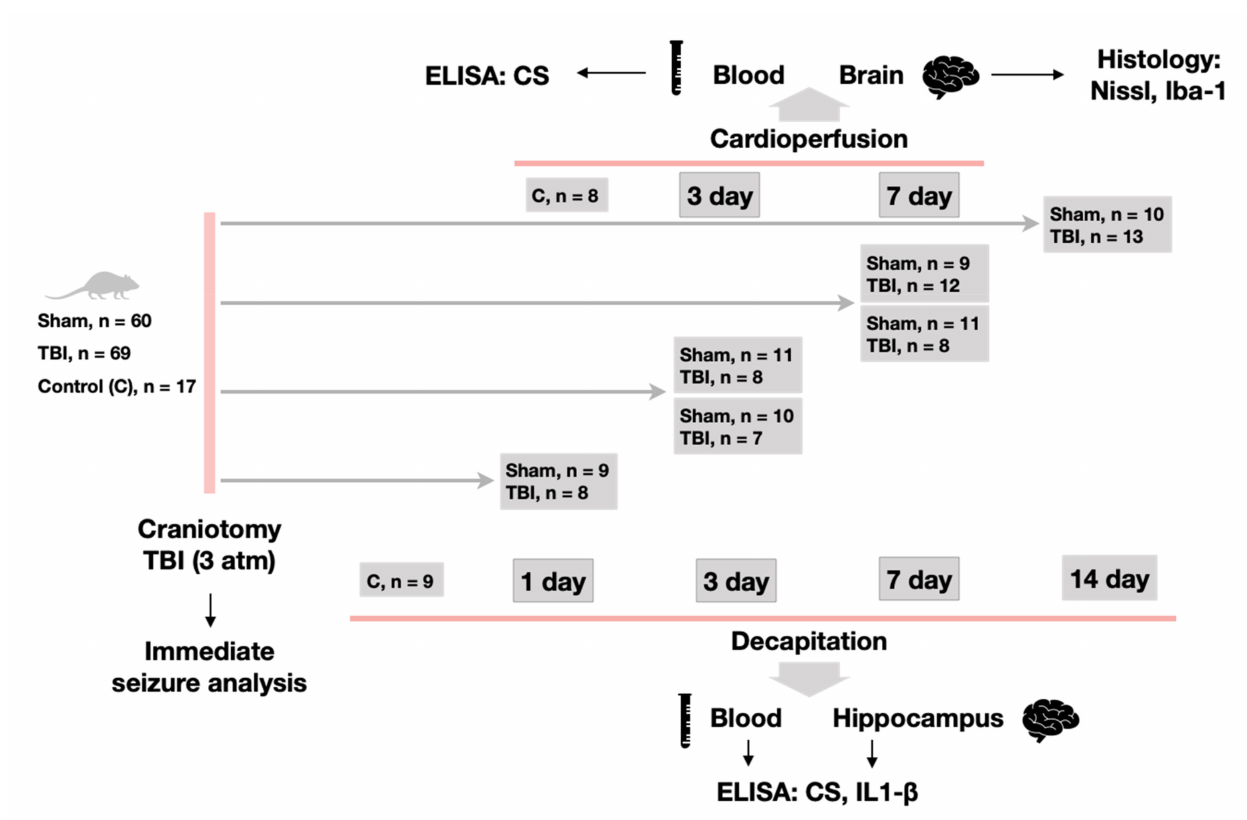
Figure 6. The design of the